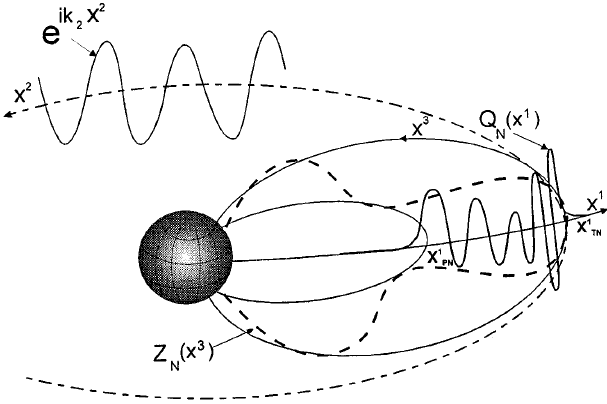
Fig. 1. Coordinate system (cid:133) x 1 ; x 2 ; x 3 (cid:134) and schematic